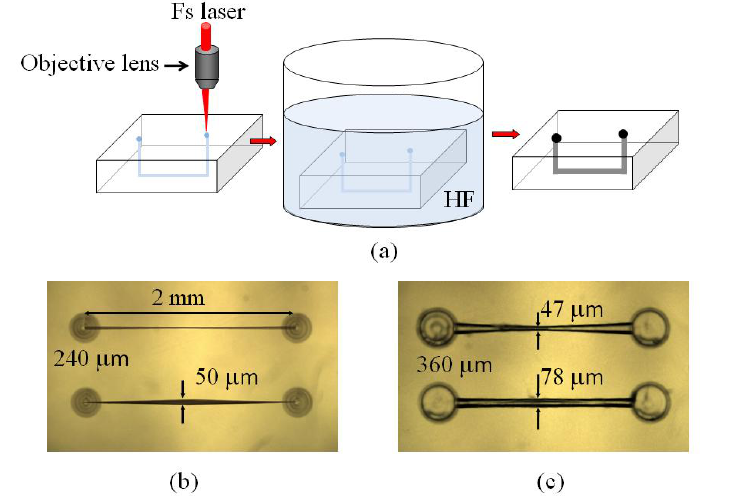
Figure 5. Femtosecond laser microfabrication of opto-microfluidic devices: ( a ) fabrication procedures, ( b ) U-shape-microchannels in fused silica before etching, and ( c ) after etching for 5 hours in 20% HF acid within a